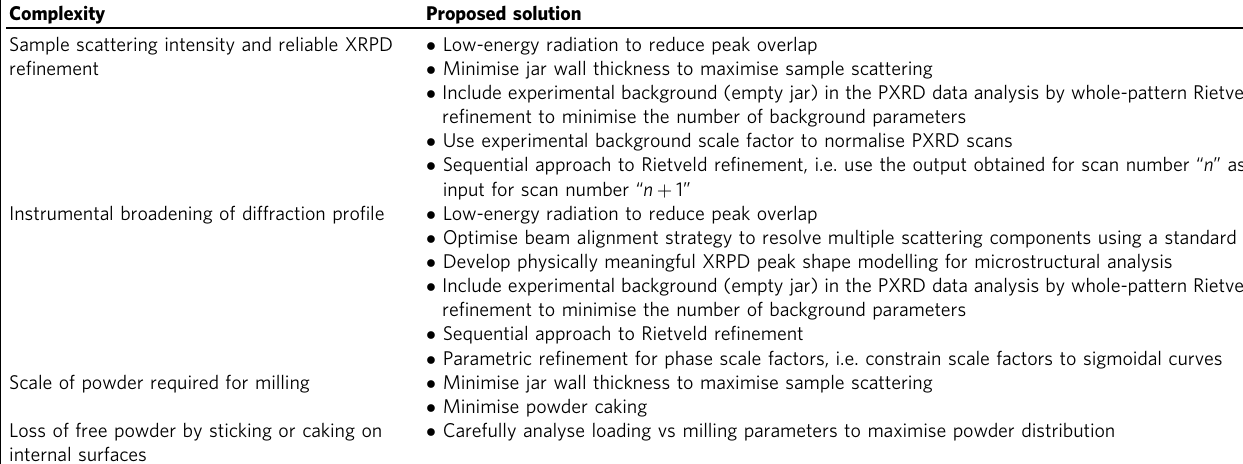
Table 1 Solutions to long-standing complexities with TRIS-XRPD analysis for ball milling reactions.